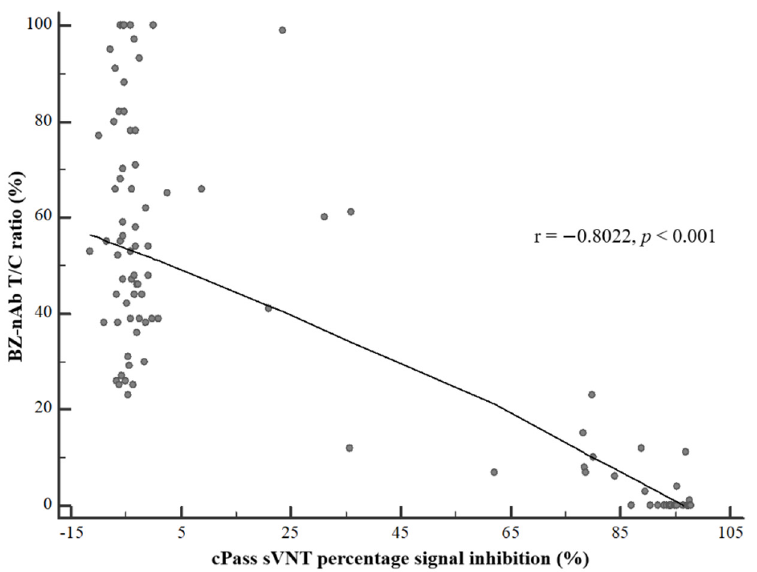
Figure 4. Correlation between the BZ-nAb T/C ratio and cPass sVNT percent inhibition. Pearson’s correlation analysis showed a strong negative correlation between BZ-nAb T/C ratio and cPass sVNT percent inhibition (r = − 0.8022, p < 0.001) when analyzed using a total of 101 samples.